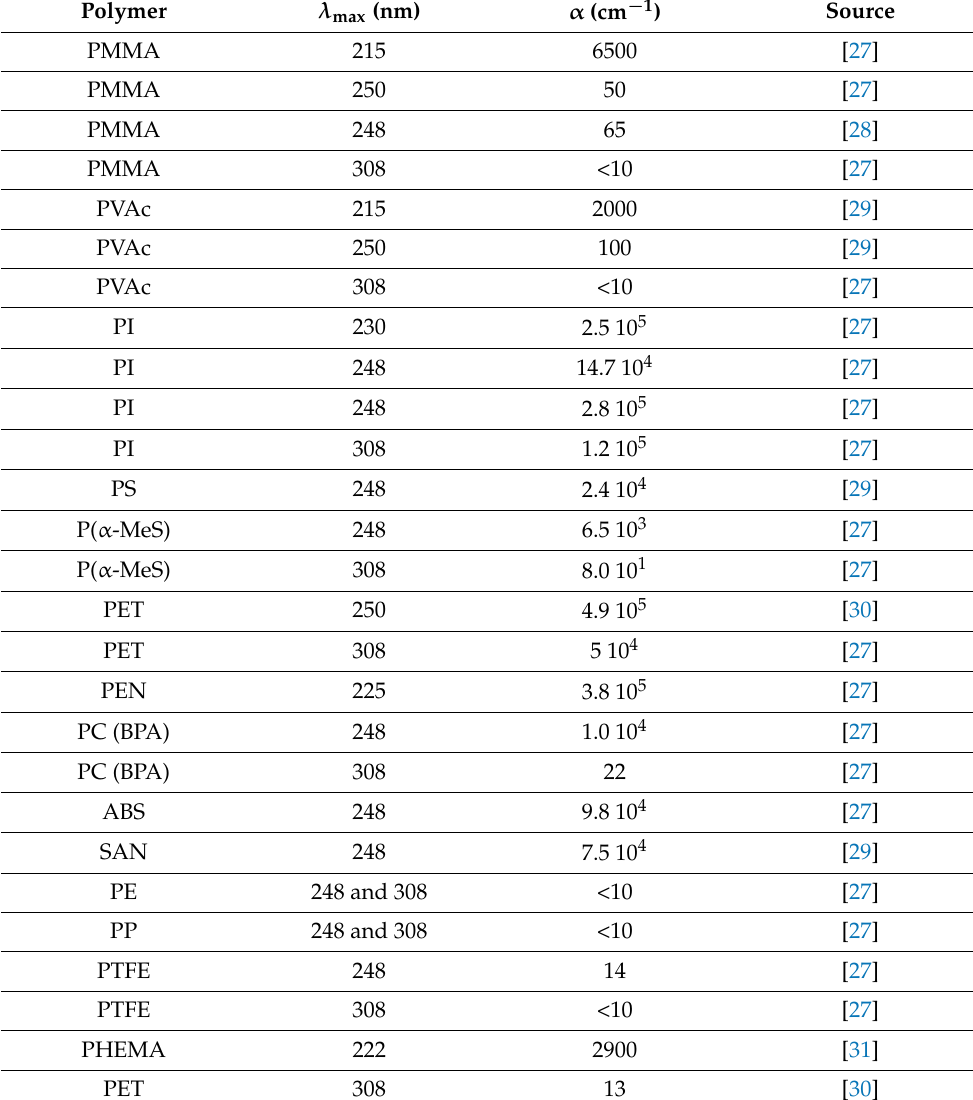
Table 1. Absorption coefficients ( α ) of common polymers at the wavelengths relevant for DLIP.